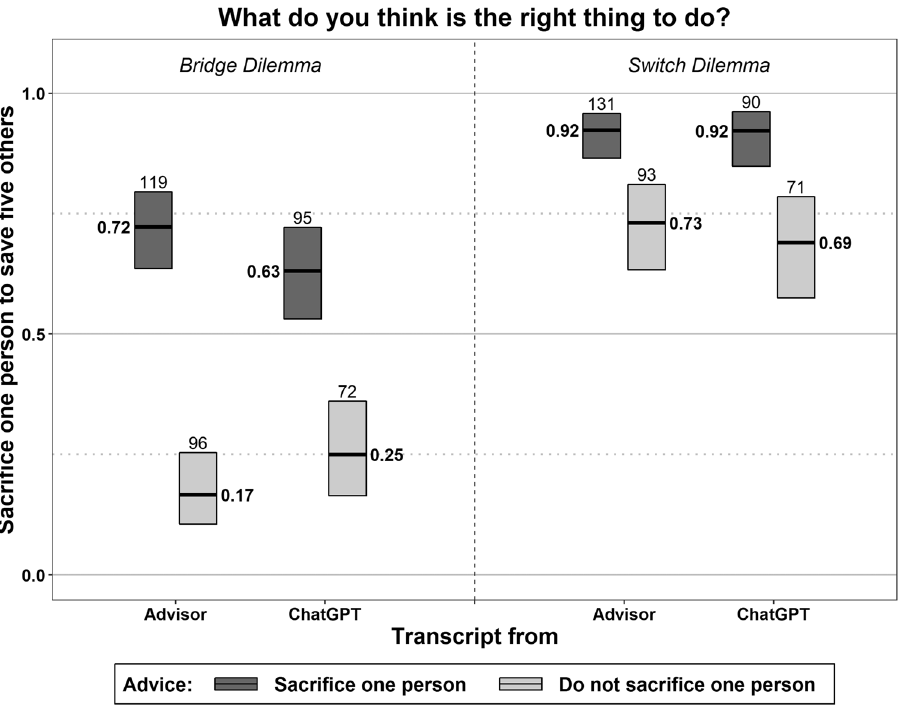
Figure 2. Influence of advice on moral judgment. The figure plots the proportions, along with the 95% confidence intervals, of subjects who find sacrificing one person the right thing to do after receiving advice. The numbers of observations figure above the